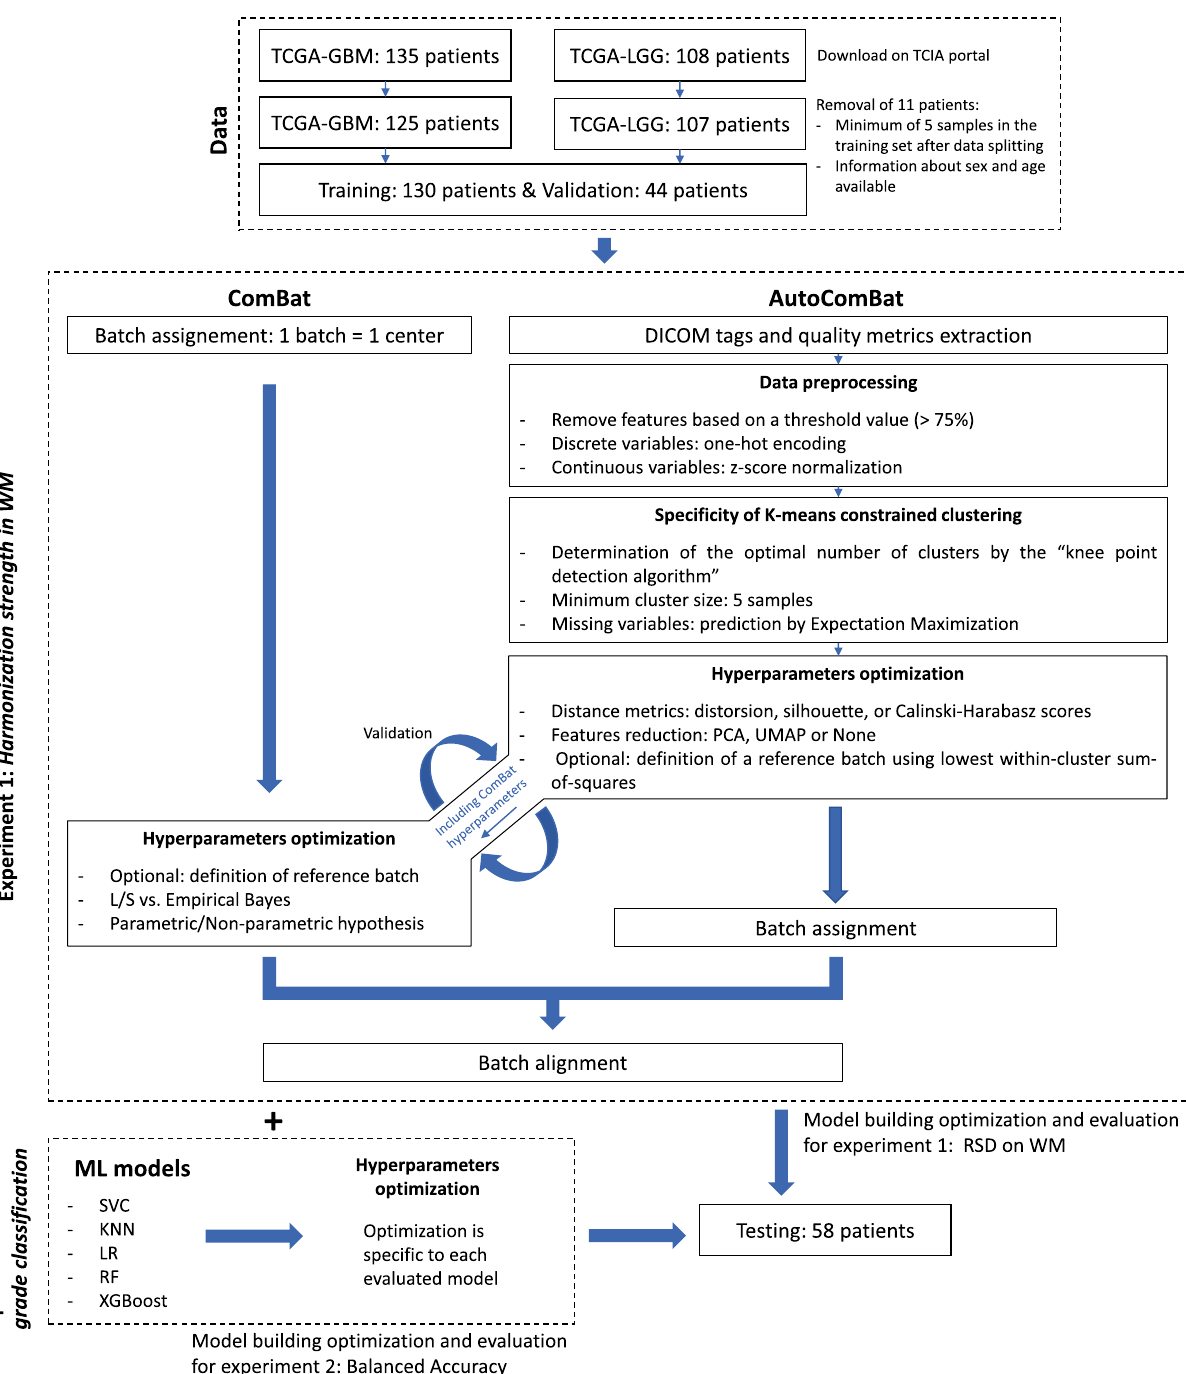
set, except for AutoComBat (all) in the T2w-flair images, which had shown the best performance in the valida- tion set but did not generalize the same way in the test set. Figure 6 attempts to interpret the clusters by showing the normalized feature importance of each feature when running AutoComBat on T1w-gd images. We remind that the variables have been previously scaled between 0 and 1. Fig. 6A,B consider all features (Metadata and QM), while Fig. 6C,D are focused on QM only. The selected hyperparameters were similar for both with empirical _ bayes = True , parametric = True , use _ ref _ batch = True , metric = distortion , except for the feature reduction method with UMAP for one (Fig. 6B) and PCA for the other (Fig. 6D). Based on Fig. 6A, we can see that 4 clusters were selected for RSD minimization considering all features. Cluster 2 contained only images with both a high number of rows and columns and low repetition